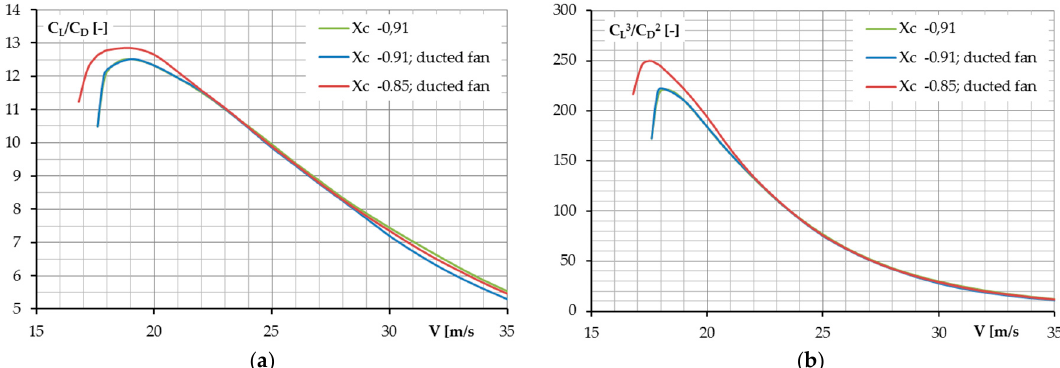
Figure 23. Variation in the airplane’s aerodynamic characteristics with CG position for the configuration with a ducted fan: ( a ) C L / C D ratio; and ( b ) power coefficient C L3 / C D2 with respect to the airspeed.